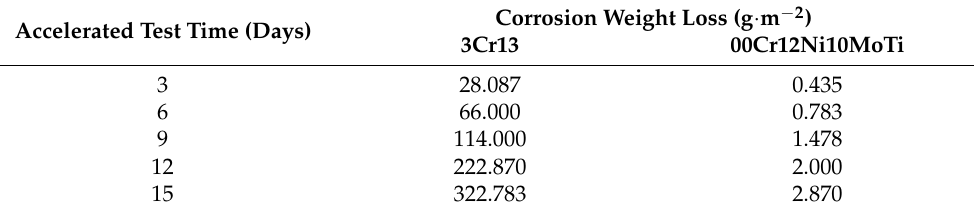
Table 5. Corrosionweight-lossdataoftwostainlesssteelsinlaboratoryartificiallyacceleratedenvironment. Accelerated Test Time (Days)